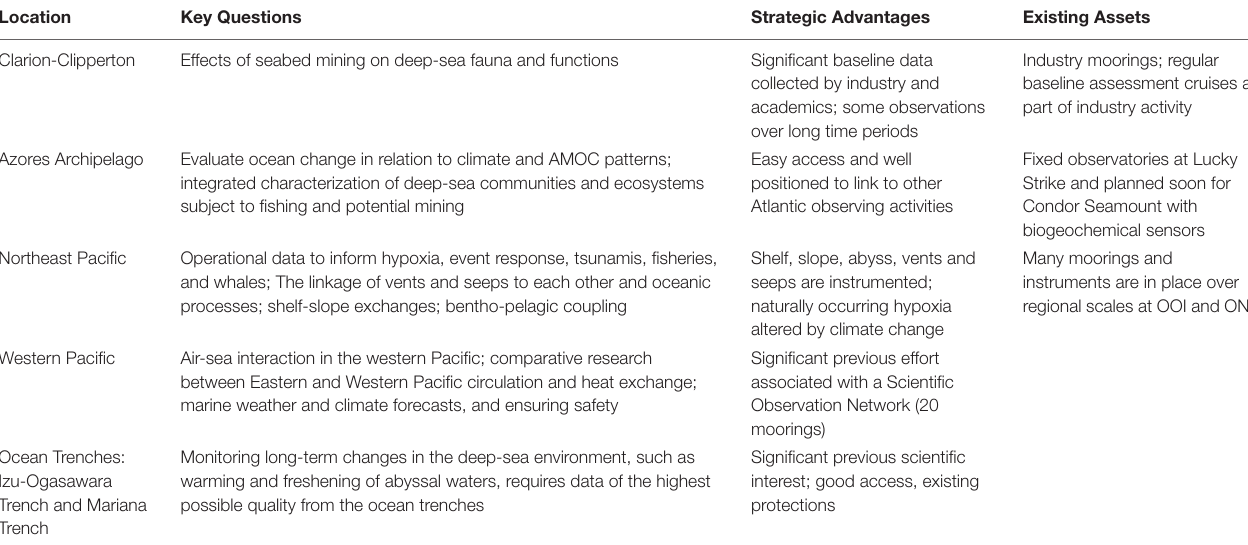
TABLE 3 | Summary of possible demonstration projects, questions, advantages and